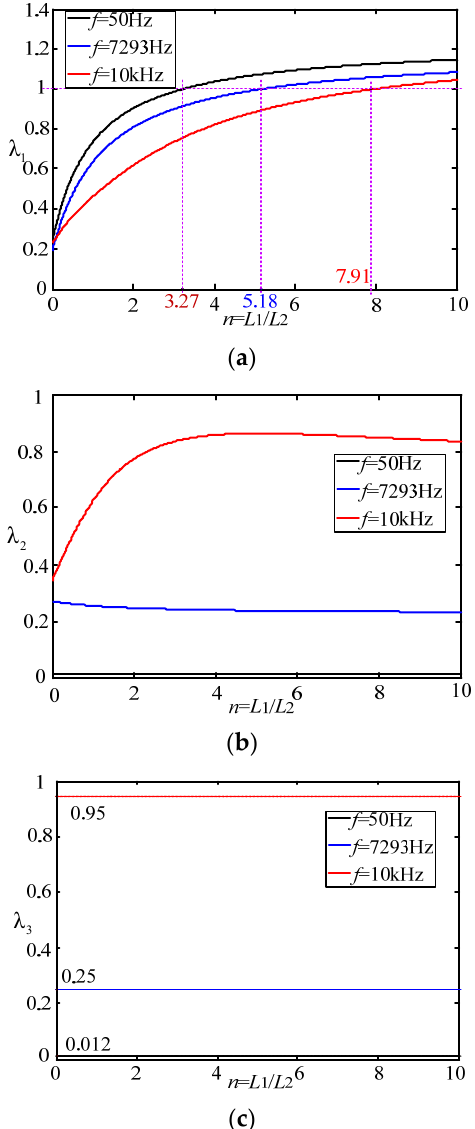
Figure 7. Power dissipation ratio analysis for different split inductor ratios. ( a ) Power consumption ratio of split inductor solution 1 and conventional solution; ( b ) Power consumption ratio of split inductor solution 2 and conventional solution; ( c ) Power consumption ratio of split inductor solution 2 and solution 1.